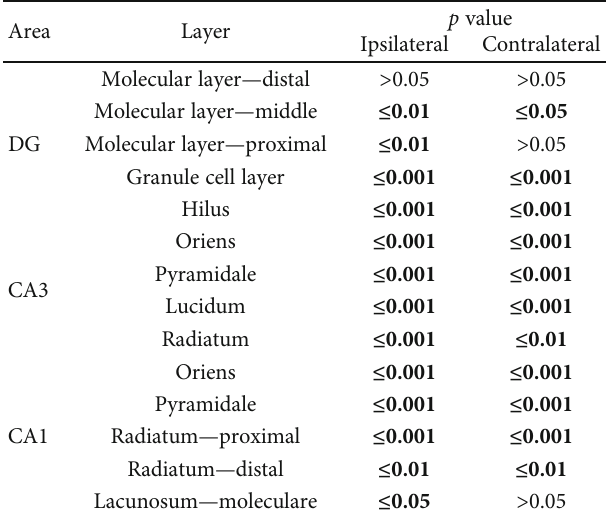
Figure 4: VGLUT-2 puncta density decreases in the granule cell layer of the dentate gyrus two weeks following noise exposure. (a) Representative images of VGLUT-2 labeling in the granule cell layer of the DG (DG-g) at 400x magni fi cation. Scale bar, 50 μ m. (b) Mean ( ± SEM) VGLUT-2 puncta density (per 10 4 μ m 2 ; normalized to respective control) in the granule cell layer. # When compared to the controls (dashed line), p ≤ 0 : 05 . Table 1: VGAT labeling in the hippocampus was decreased signi fi cantly in most areas two weeks after noise exposure with t